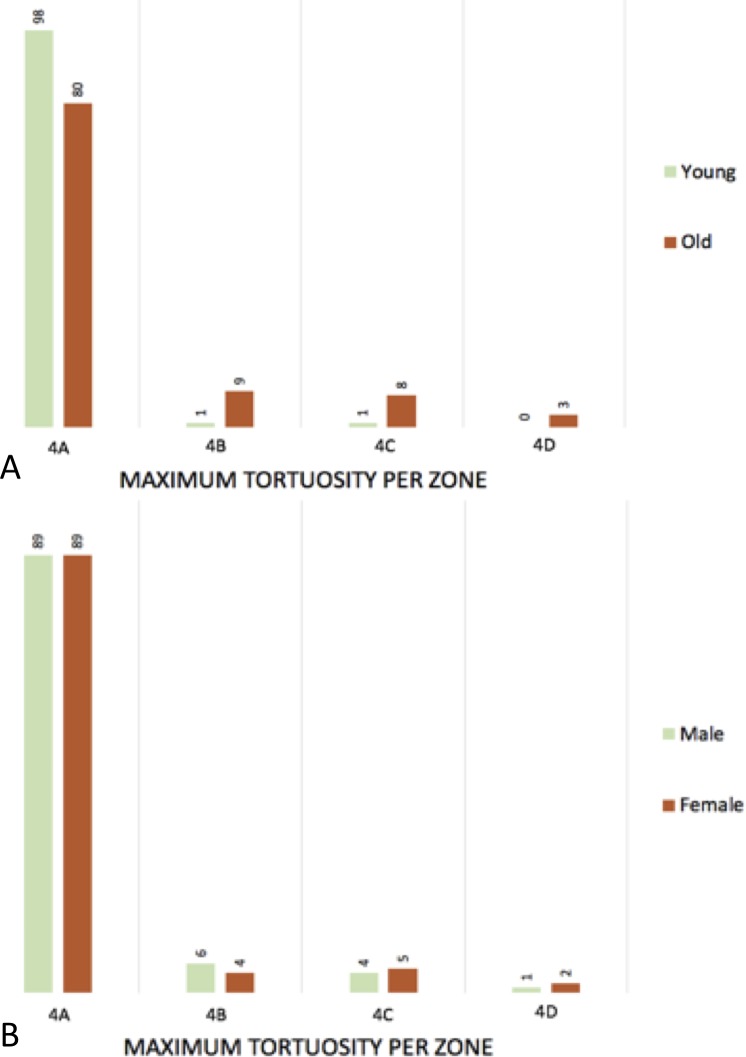
Histogram of the maximum tortuosity per zone.A: young vs. old; B: male vs. female.